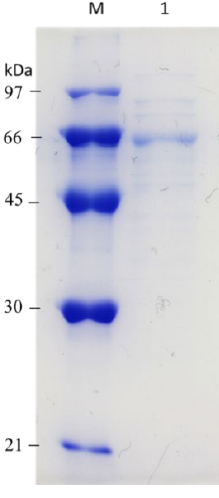
Figure 3. SDS- PAGE of the purified β -1,3-glucanase from Y. lipolytica transformant (pYLSC1- 13g ). Lane M: molecular weight marker; Lane 1: purified β -1,3-glucanase.